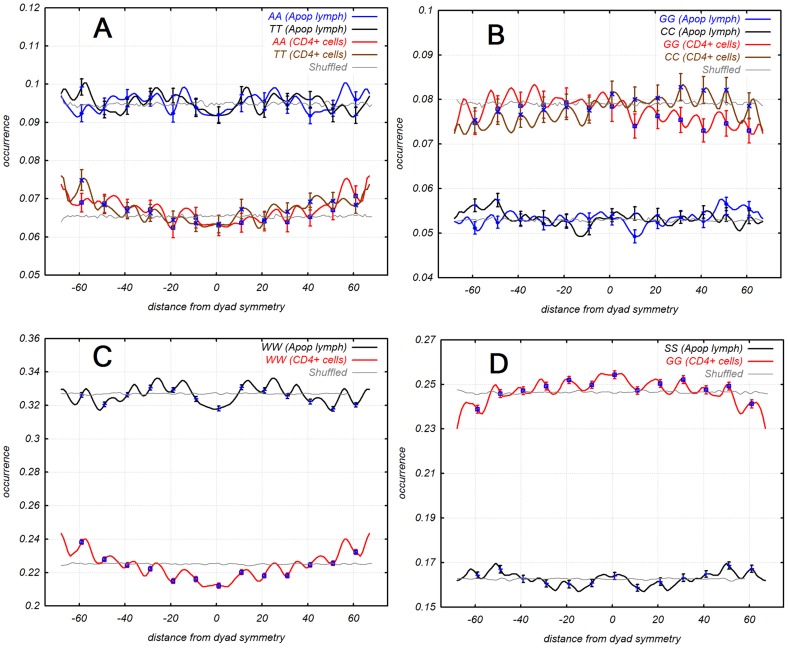
Dinucleotide distributions of (A) AA-TT and (B) GG-CC dinucleotides, (C) WW (adenine or thymine), and (D) SS (guanine or cytosine) around nucleosome dyad symmetry, whole sets.Apoptotic lymphocytes, data is from [14]; CD4+ cells, data is from [8].